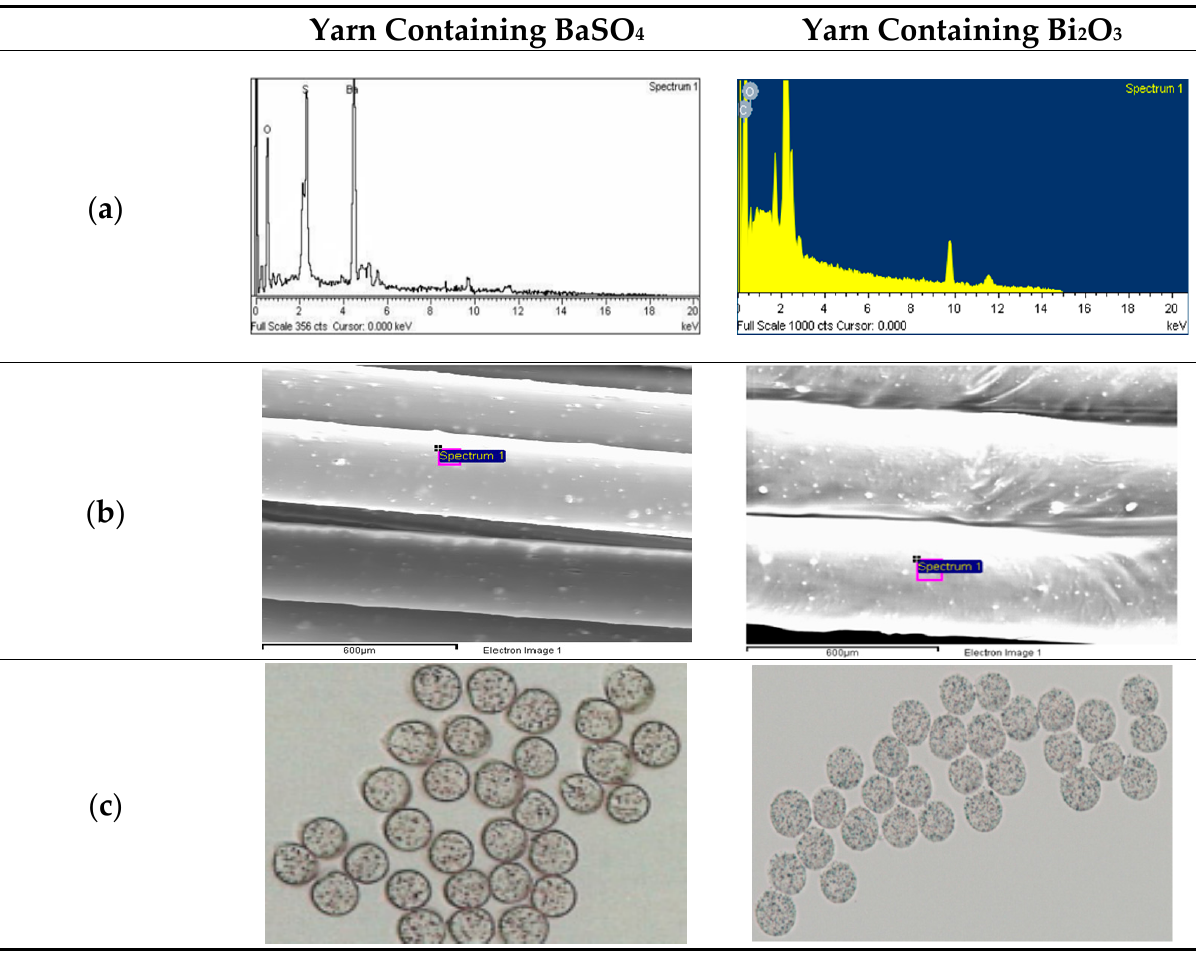
Figure 5. Radiation-shielding fiber yarn analysis: ( a ) results of energy-dispersive X-ray spectroscopy (EDS) analysis of yarn components, ( b ) cross-section SEM images (400×), and ( c ) surface SEM images (600×).